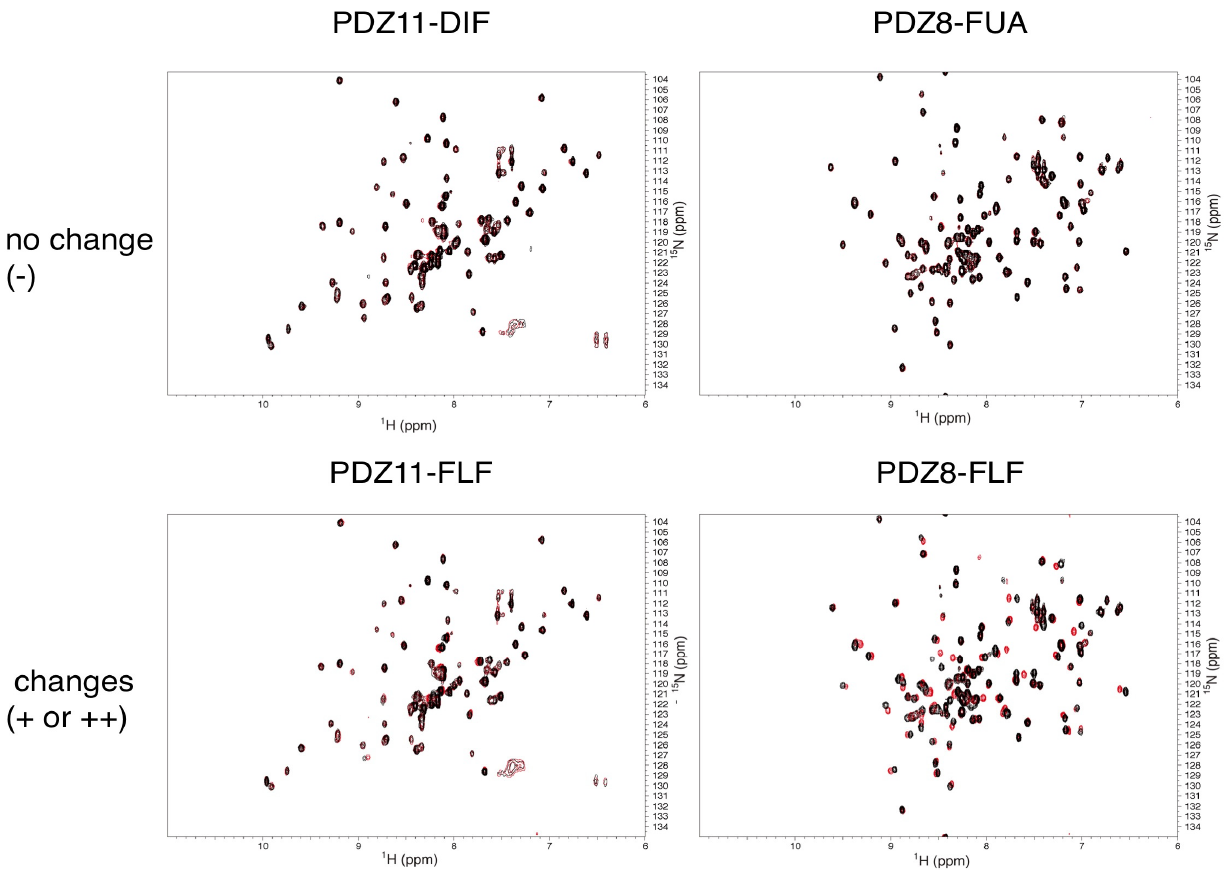
Figure 2. Examples of NMR titration of PDZ domains with each compound. Each overlaid spectrum was derived from a PDZ domain with (red) and without (black) the compound. Upper spectra show results where no signal changes were observed after mixing the PDZ domain with a compound. Lower spectra show the signal changes of the PDZ domain when mixed with a